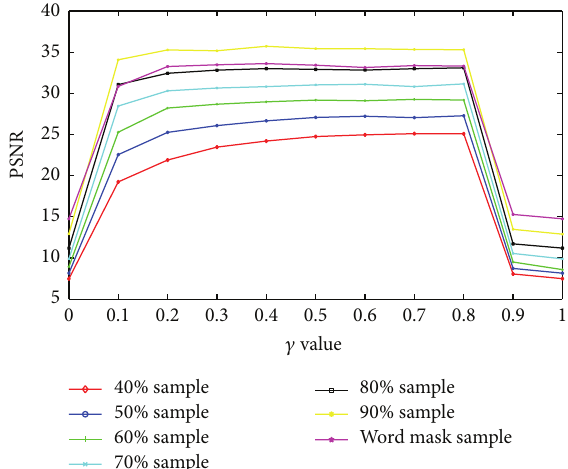
Figure 2: The recovered PSNR for Pepper under different random sample ratio and word mask sample with 𝛾 from 0 0 to 1 by LTVNN.